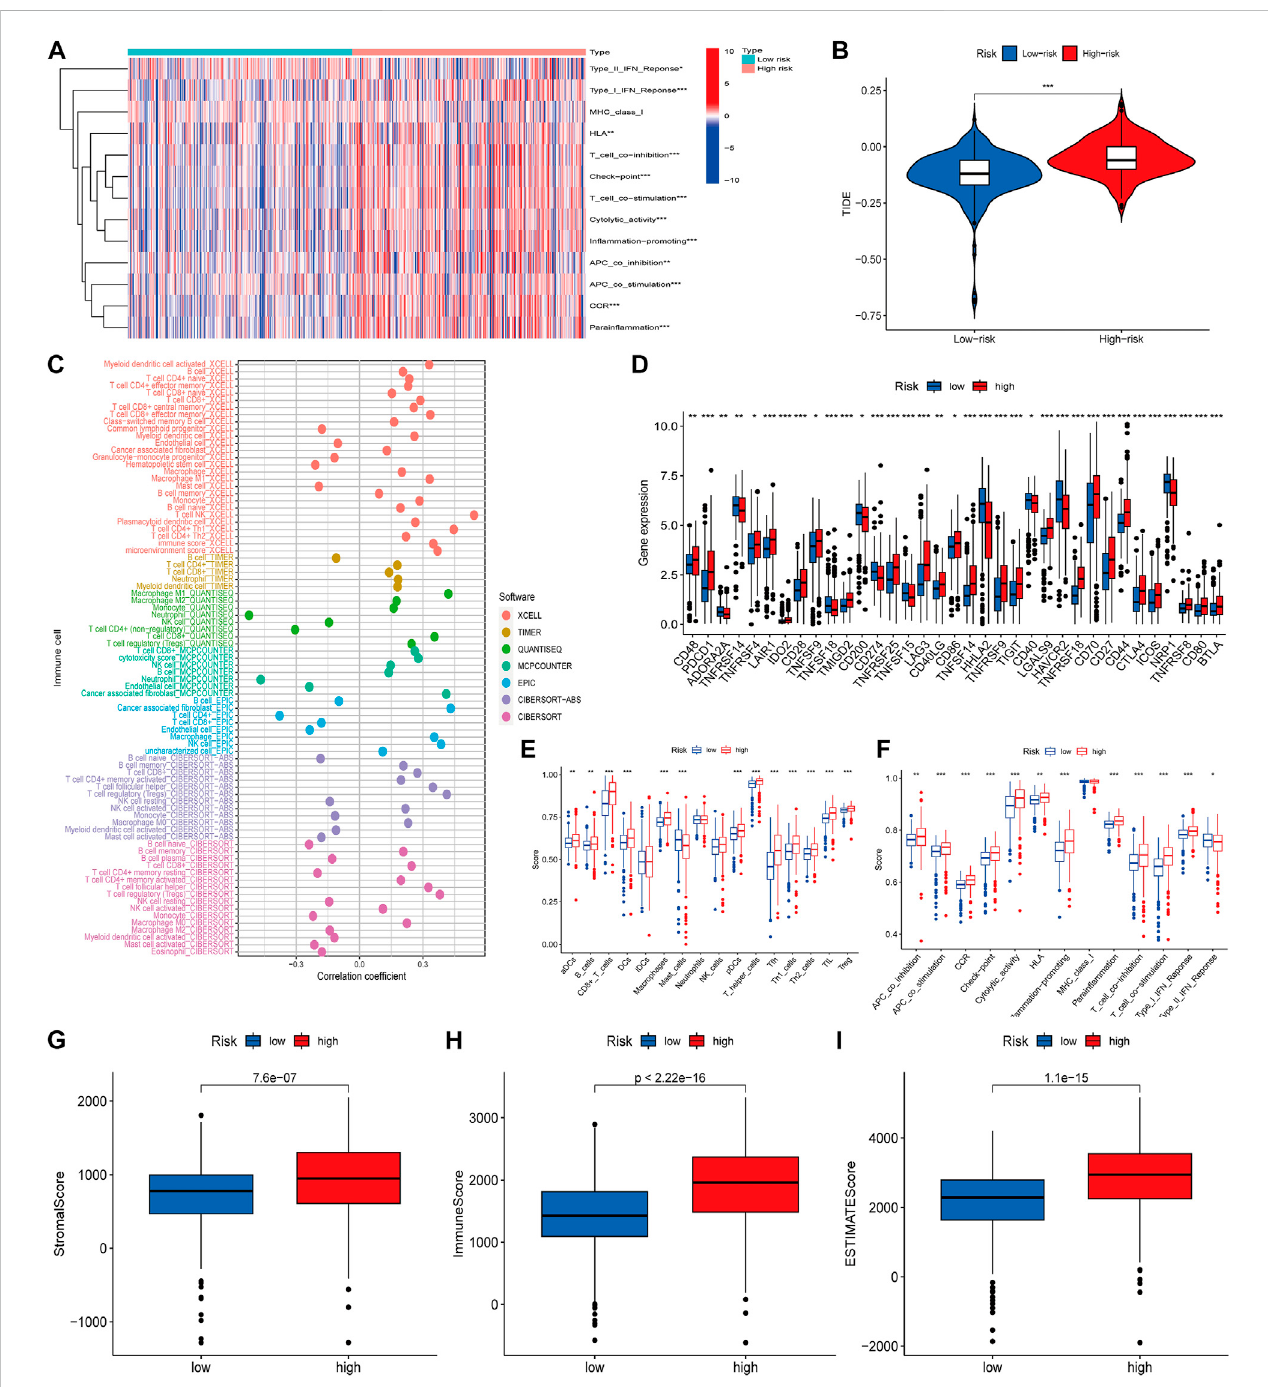
FIGURE 6 (A) Heat map of immune function differences. (B) Scoring of immune escape and immunotherapy in high- and low-risk groups. (C) Correlation coef fi cientsbetweenimmunecells andriskscores, differentcolors representing differentsoftware predictions (D) Differential analysisofimmunecheckpoint related genes between high- and low-risk groups (E,F) Difference analysis of ssGSEA between immune cells and immune-related functions in high and low riskgroups (G – I) The number ofstromal cells, immunecell content,and comprehensive scoringoftumormicroenvironment